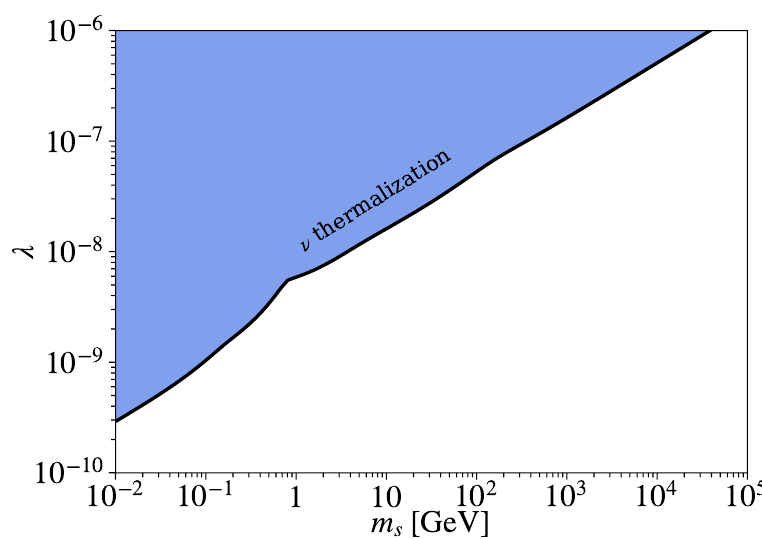
Figure 2 . Sterile neutrino non-thermalization bound. The neutrinos are produced via s ! (cid:23)(cid:23) with s in thermal equilibrium and m s (cid:29) M . In the shaded region, n (cid:23) & n eq process (cid:23)(cid:23) ! s is